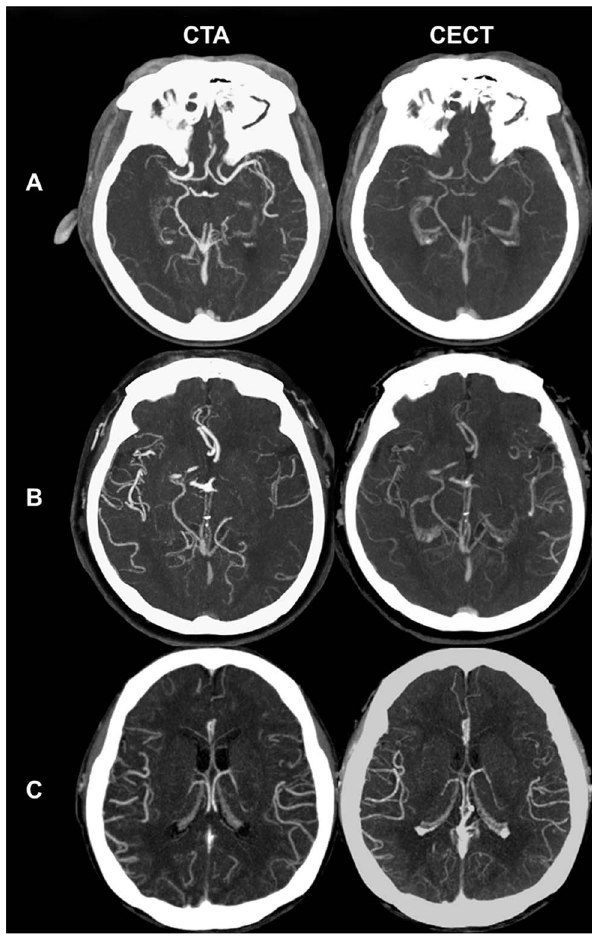
Figure 1. Representative images of collateral status on dual- phase CT. A, Some collaterals to the right MCA territory on CTA with persistence of some defects on CECT (Grade 1). B, Collaterals in part of the left MCA territory on CTA with complete filling on CECT (Grade 2). The collaterals show lower attenuation on CTA with equal to higher attenuation on CECT than unaffected vessels, suggesting slow inflow and washout of collaterals. C, Collaterals in the entire right MCA territory on both CTA and delayed CECT (Grade 3). The collateral vessels show attenuation similar to unaffected vessels on both phase images, suggesting fast velocity of